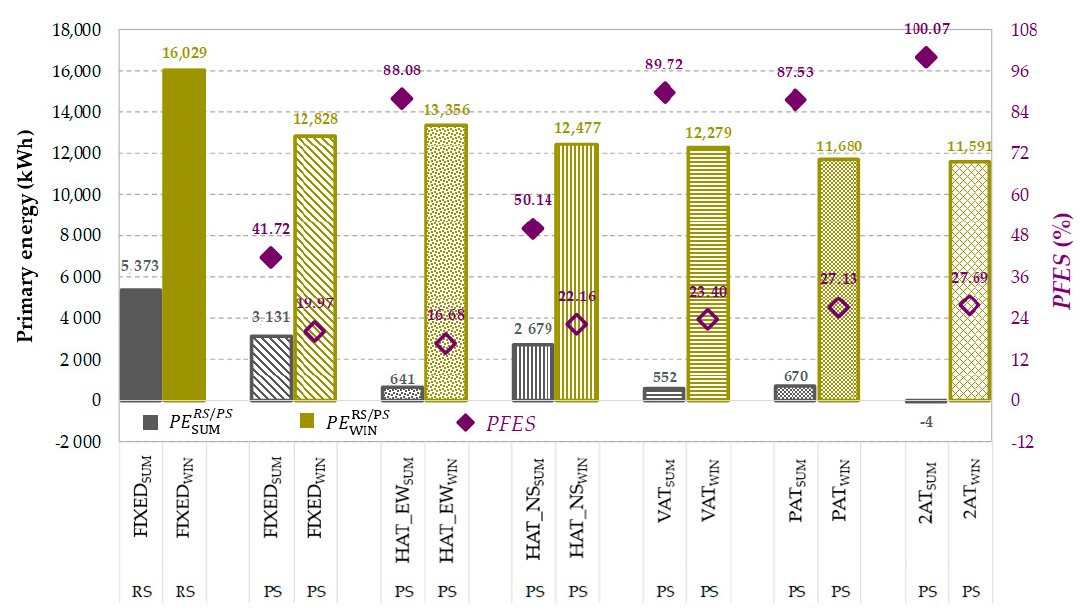
Figure 8. Primary energy demand of RS and PS, PFES index in Scenario_YV.